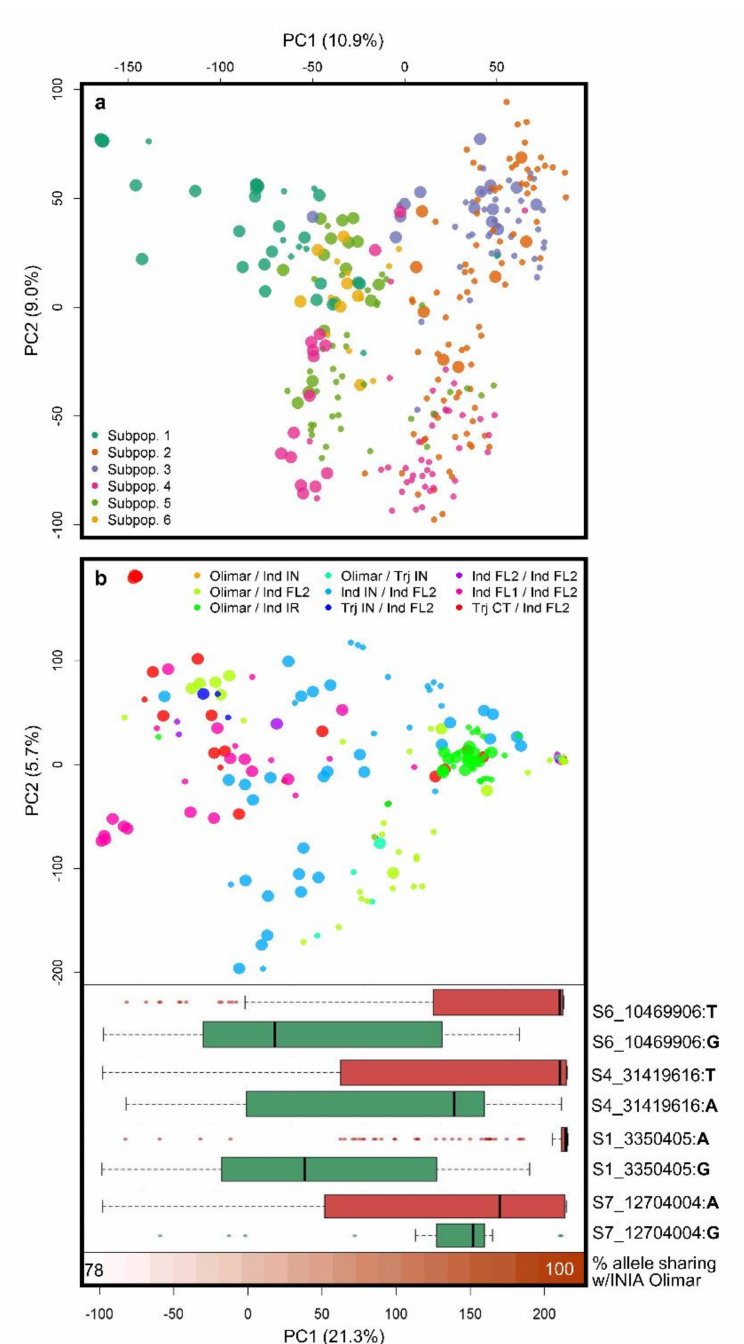
Figure 2. Principal component (PC) showing population structure of the two mapping populations used in this study. ( a ) PC analysis of 28850 SNP from 245 tropical japonica rice advanced inbred lines. Pedigree based groups are color coded and point sizes represent the allele of S9_9786203 (small = S9_9786203:T, big = S9_9786203:C). ( b ) Upper section: PC analysis of 49589 SNP from 305 advanced indica rice inbred lines. Parents’ origins are color coded, and point sizes represent the allele of S6_10469906 (small = T, big = G). Origins of parents of pedigree groups: Olimar = susceptible indica cultivar INIA Olimar (Uruguay); Ind IN = indica type inbred lines from the National Institute of Agricultural Research (INIA, Uruguay); Ind FL1 = old indica type inbred lines from the Latin American Fund for Irrigated Rice